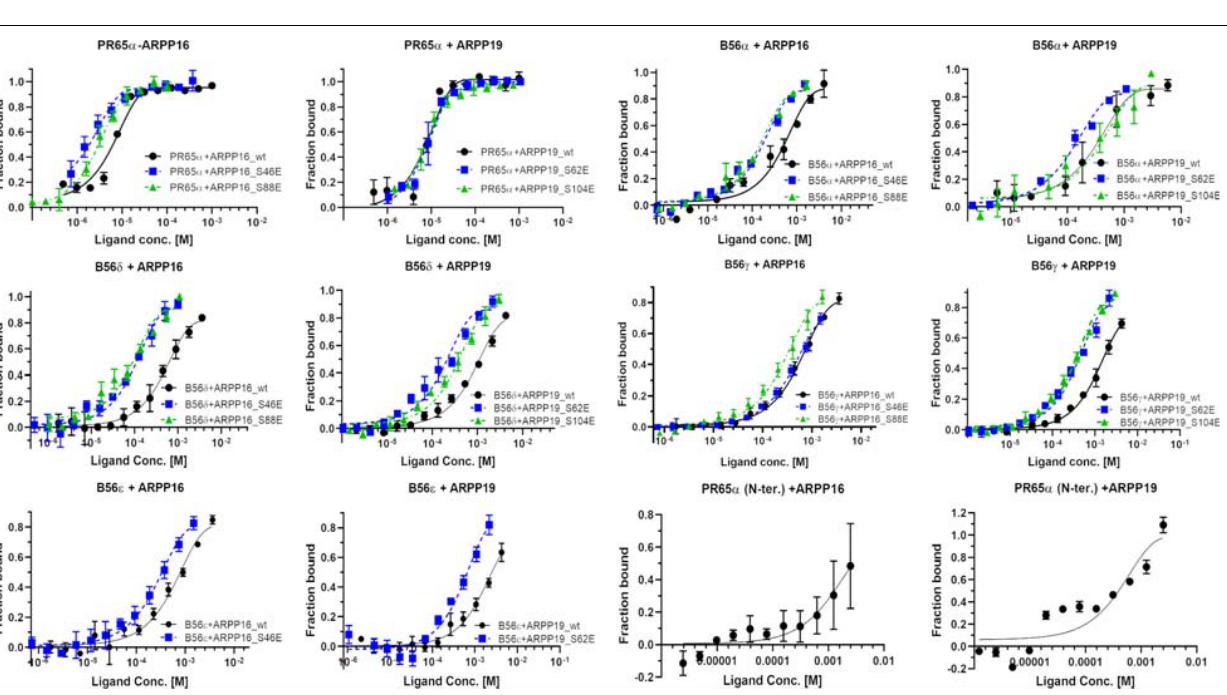
Frontiers in Molecular Biosciences |